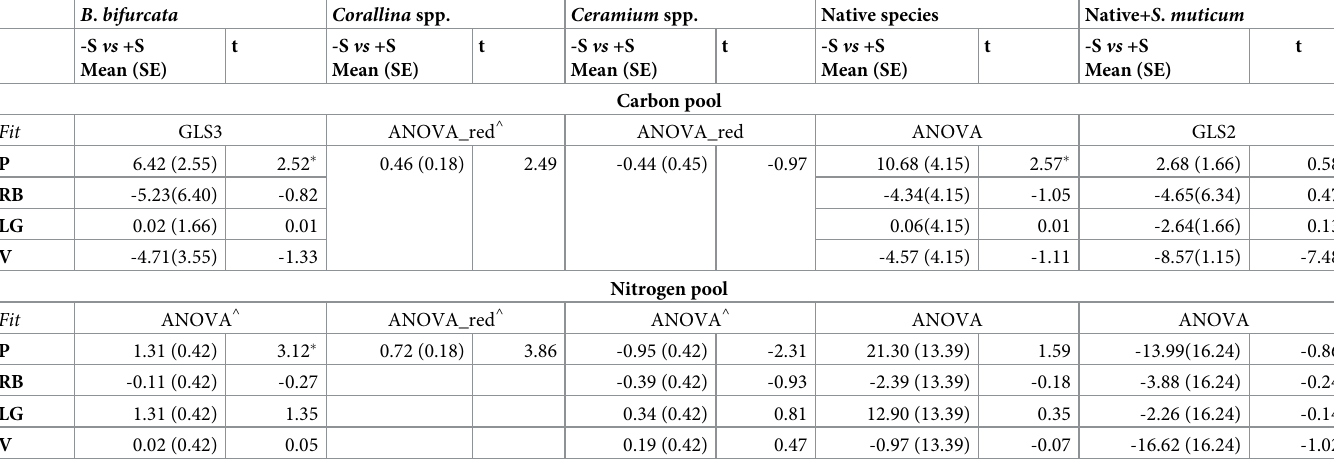
Table 4. Parameter estimates of the GLS models and t-tests for mg of 13 C-carbon and of 15 N-nitrogen stored in thalli. B . bifurcata Corallina spp. Ceramium spp. Native species Native+ S . muticum